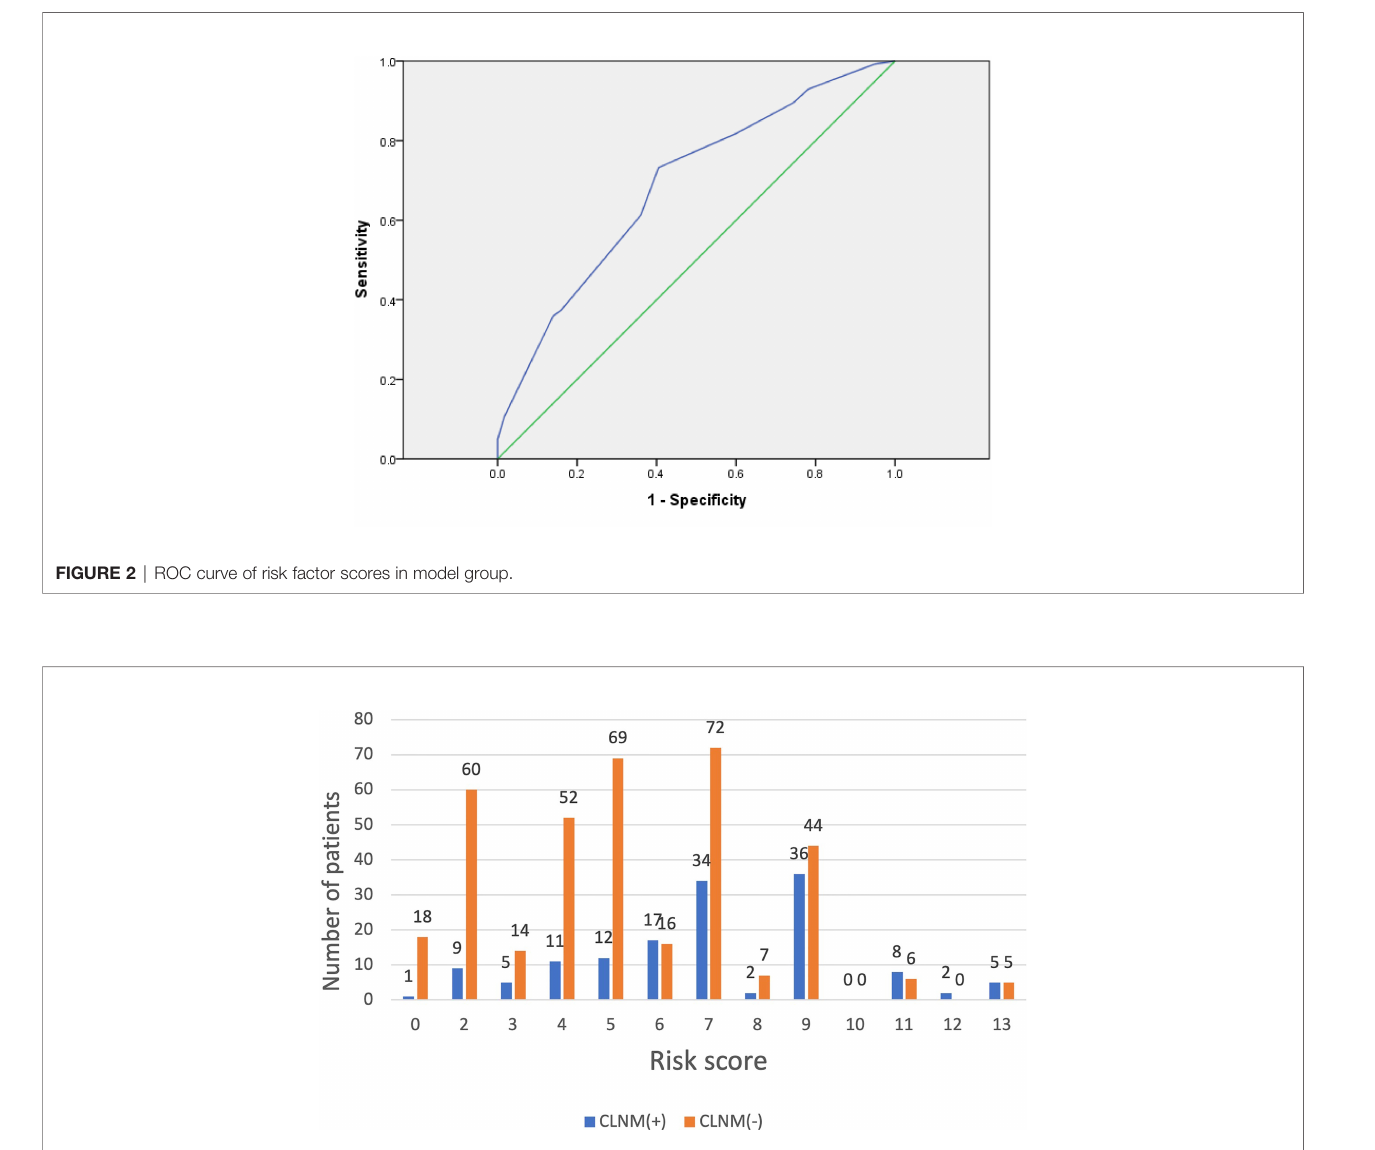
FIGURE 3 | The distribution of CLNM-negative and positive patients with different risk scores inthe model group.